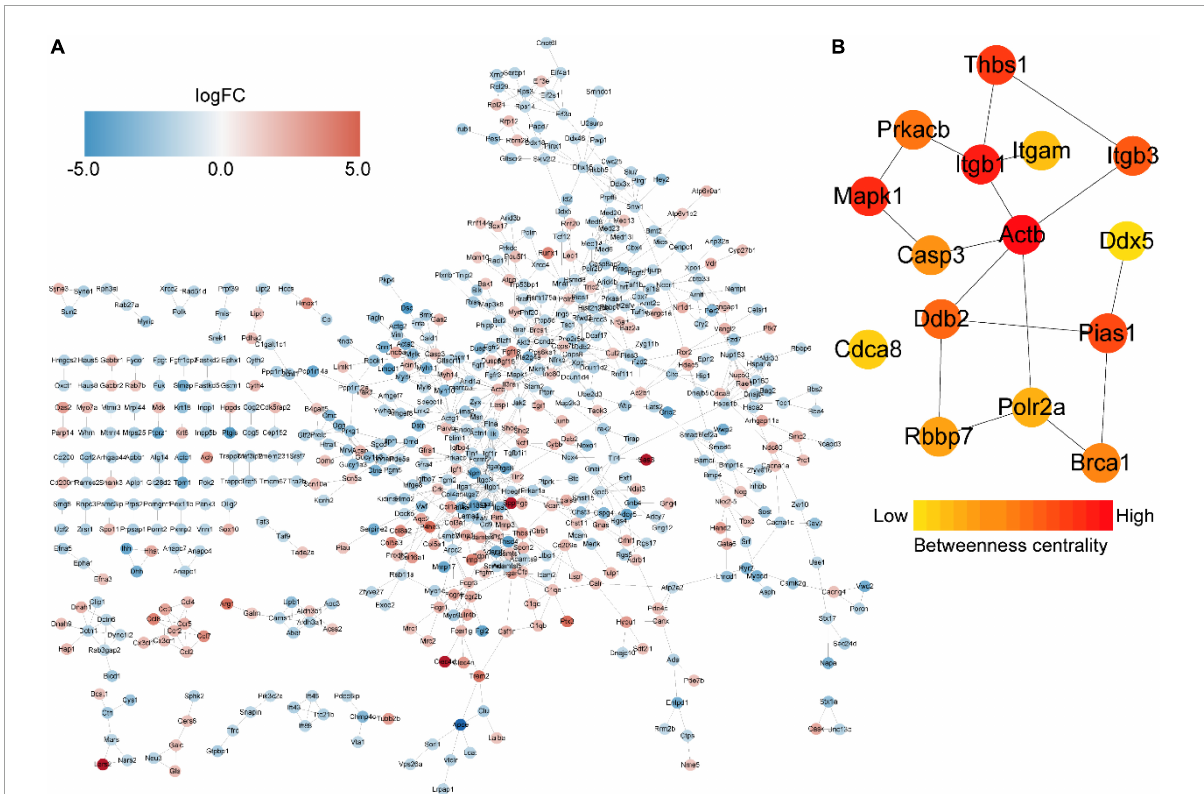
FIGURE5 Protein–protein interaction (PPI) networks and hub genes of differentially expressed mRNAs (DEmRNAs) in aortic dissection (AD) tissues compared with controls. (A) PPI networks show the interaction of DEGs, with interaction scores > 0.9. The red to blue color gradient indicates an up- to downregulation of DEmRNAs, indicated by logFC. (B) The top 15 hub genes from DEmRNAs. The red to yellow color gradient indicates high to low centrality.